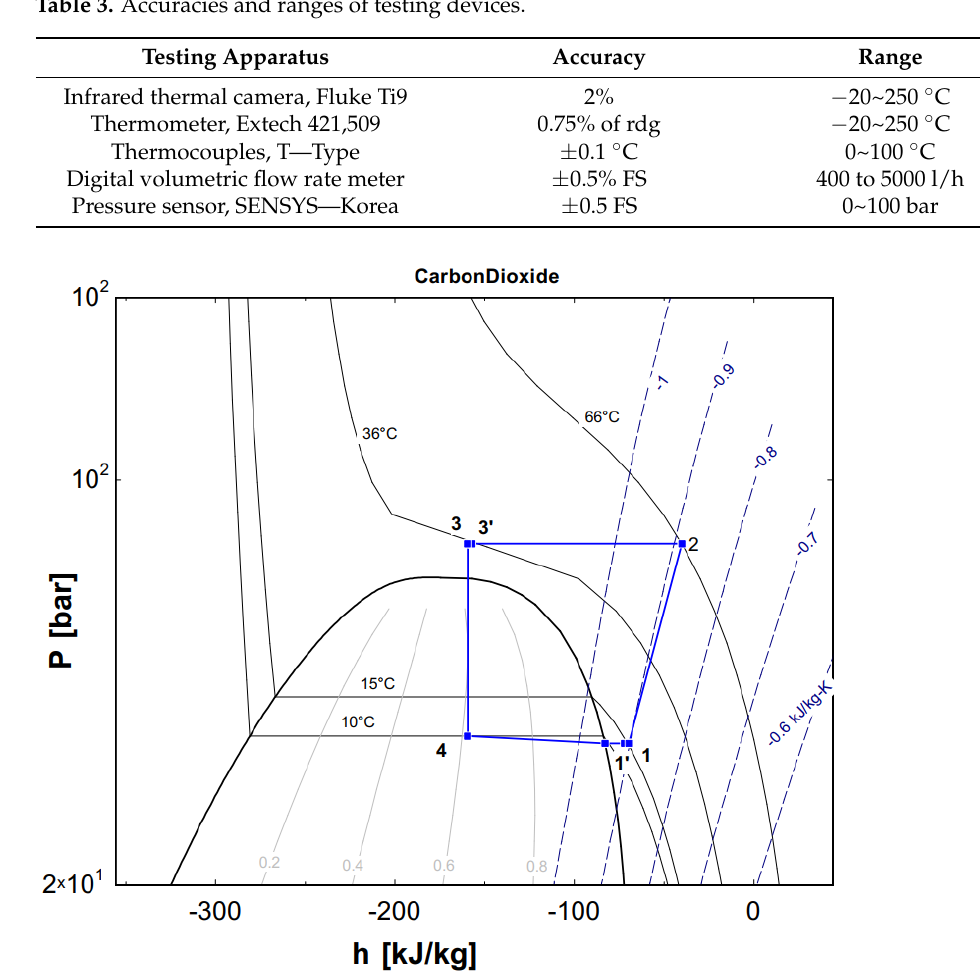
Figure 5. The experimental data presented on a p – h diagram.